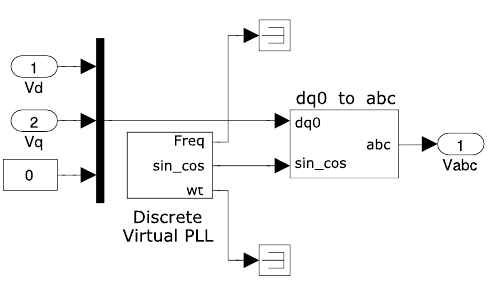
Figure 7. Conversion from dq to a, b, c system.